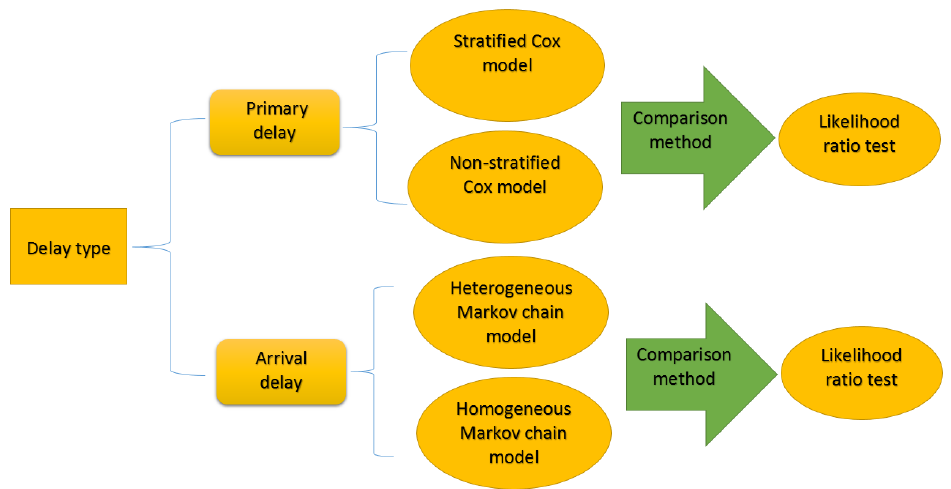
Figure 3. Statistical methodologies in the